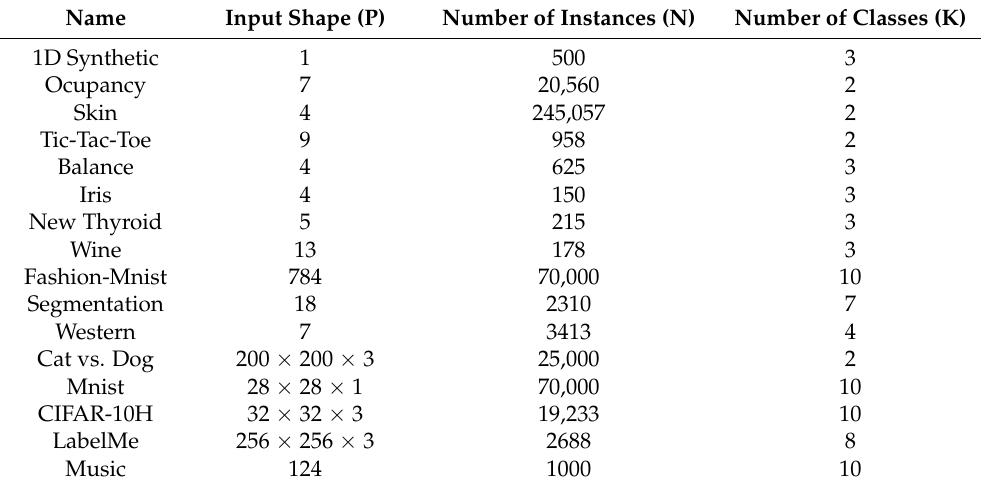
Table 1. Description of the number of features (P), instances (N), and classes (K) of tested datasets for multiple-annotator